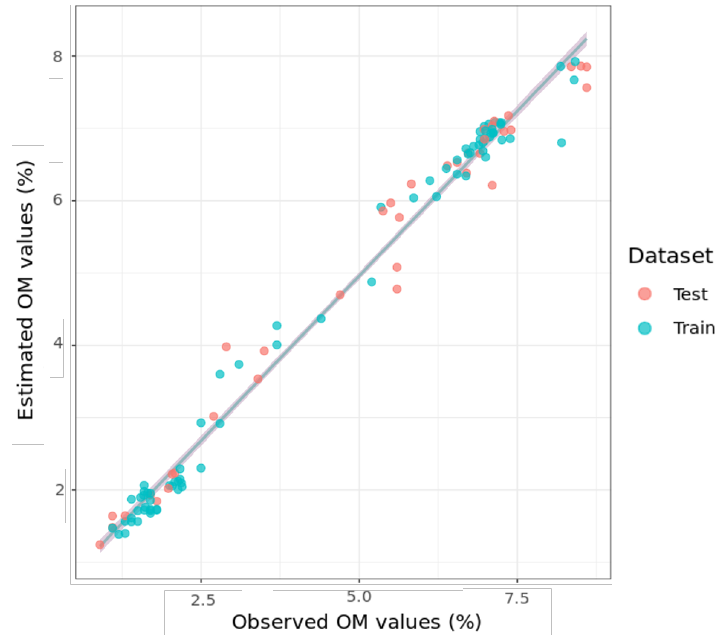
Figure 5. Scatter plot of the best fitted model (Cubist, absorbance and Savitzky–Golay 2nd derivative) for OM prediction using the laboratory (PSR+ 3500) data, including the regression line (blue) with the 95% confidence interval (grey).